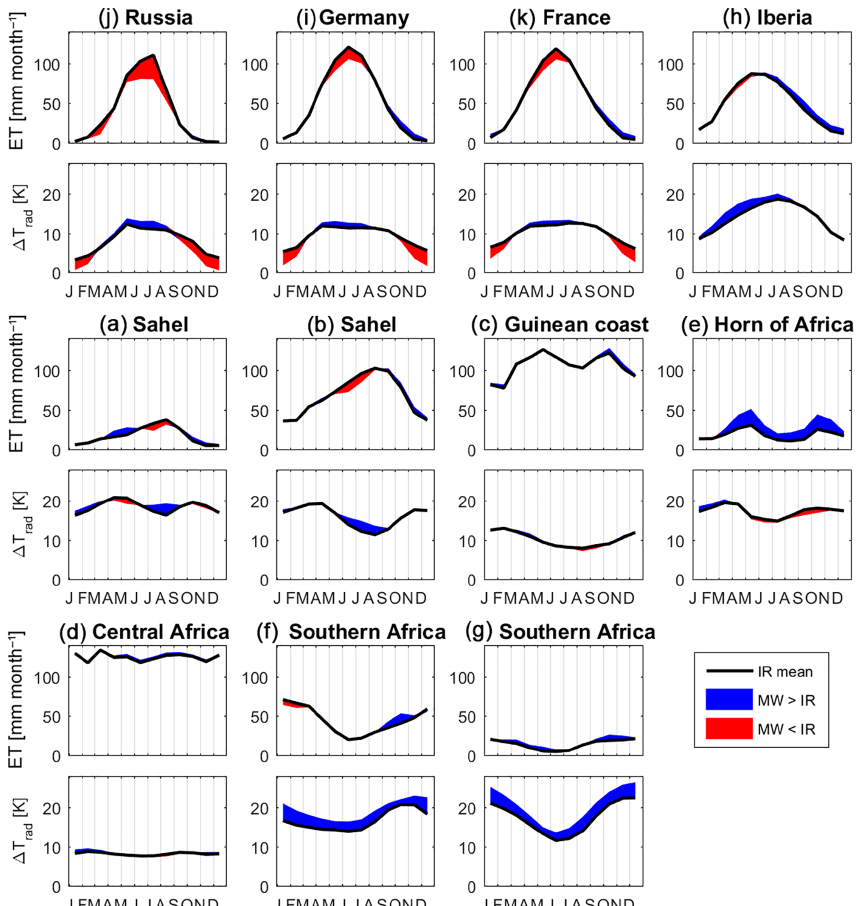
Figure 5. Mean monthly ET as estimated with ALEXI-IR over 2003–2011, and monthly means of its MODIS-based (cid:49)T rad input (pe- riod 2004–2011), for selected regions. The deviation from these IR estimates when using the MW inputs is shown in blue for a positive deviation and red for a negative